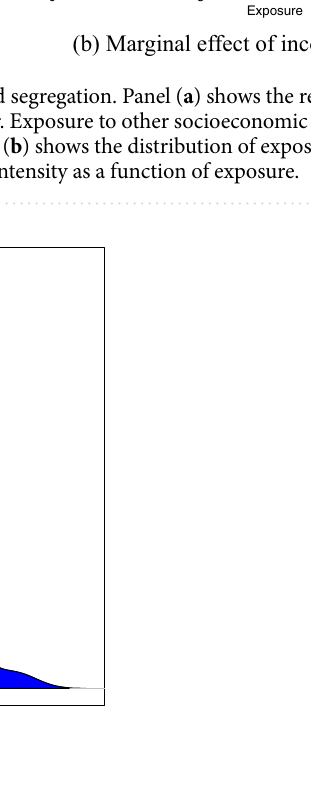
Figure 3. Clustering in networks. The figure shows the distribution of the communication weighted clustering coefficient, in random samples of 100 towers, as well as the clustering coefficient observed in the poorest (red line—to the left) and richest (blue line—to the right) 100